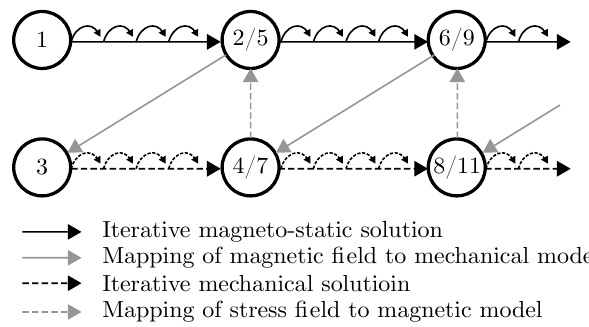
Figure 2. Adapted Conventional Serial Staggered (CSS) Coupling Procedure for the coupling of magneto-static and mechanical simulation; numbers in circles are to be understood as step